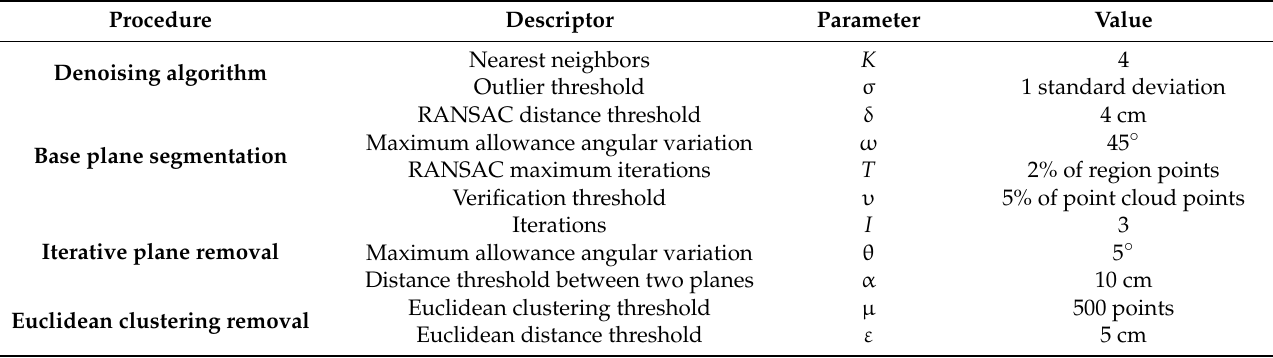
Table 4. Parameters of